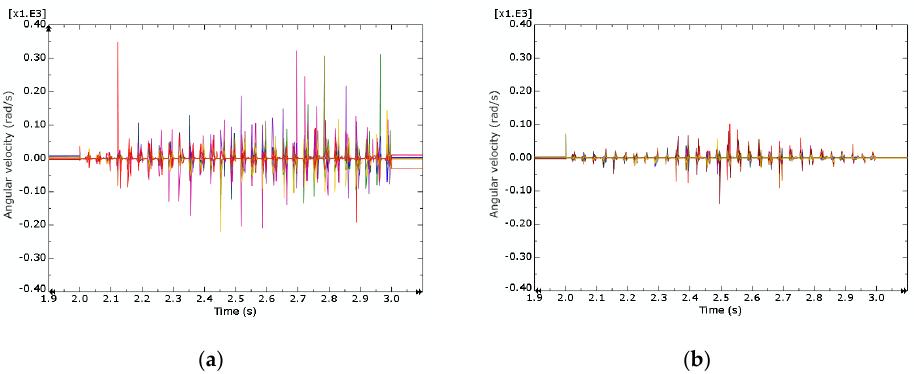
move more slowly with the rotational angular velocity within 0.25 rad/s. Figure 8. Angular velocity of different mixtures: ( a ) AC 11 in Z-direction; ( b ) PA 11 in Z-direction.